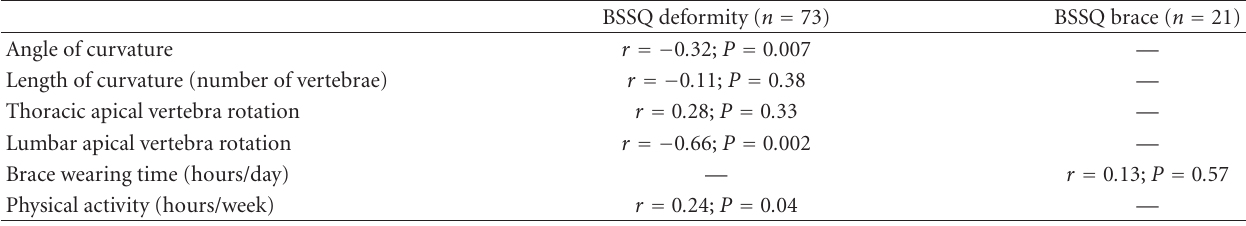
Table 3: The correlation of the BSSQs scores with the parameters of scoliosis, the time of brace wearing, and the physical activity. BSSQ deformity ( n = 73) BSSQ brace ( n = 21) Angle of curvature